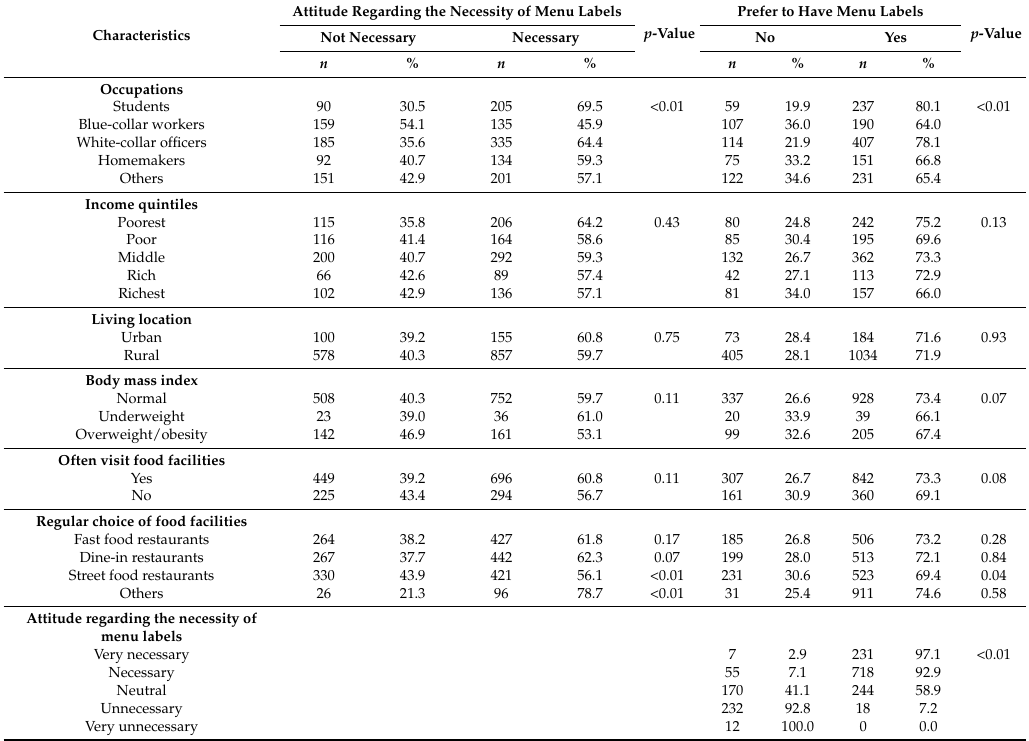
Table 4. Associated factors with the attitude and preference for calories and nutrition labeling among customers Attitude Regarding the Necessity of Menu Labels (Necessary/Not Necessary) Factors OR 95%